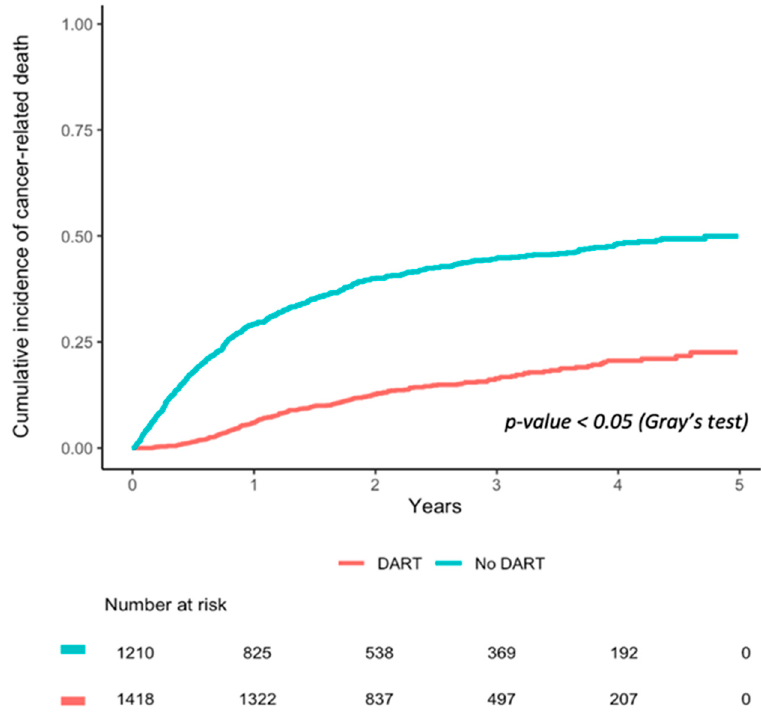
Figure 3. Cumulative incidence of cancer-related death in DART completers vs. non-completers.